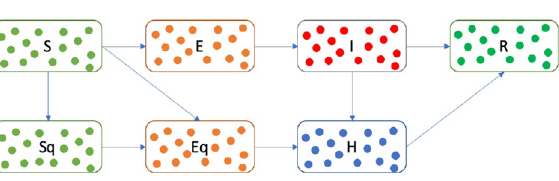
Figure 3. Extended from the SEIR model for SARS-CoV-2 26 , we propose this model to individualize the contagion process. The original model uses those seven states to separate the people states, and we extend this method to an individual process for further